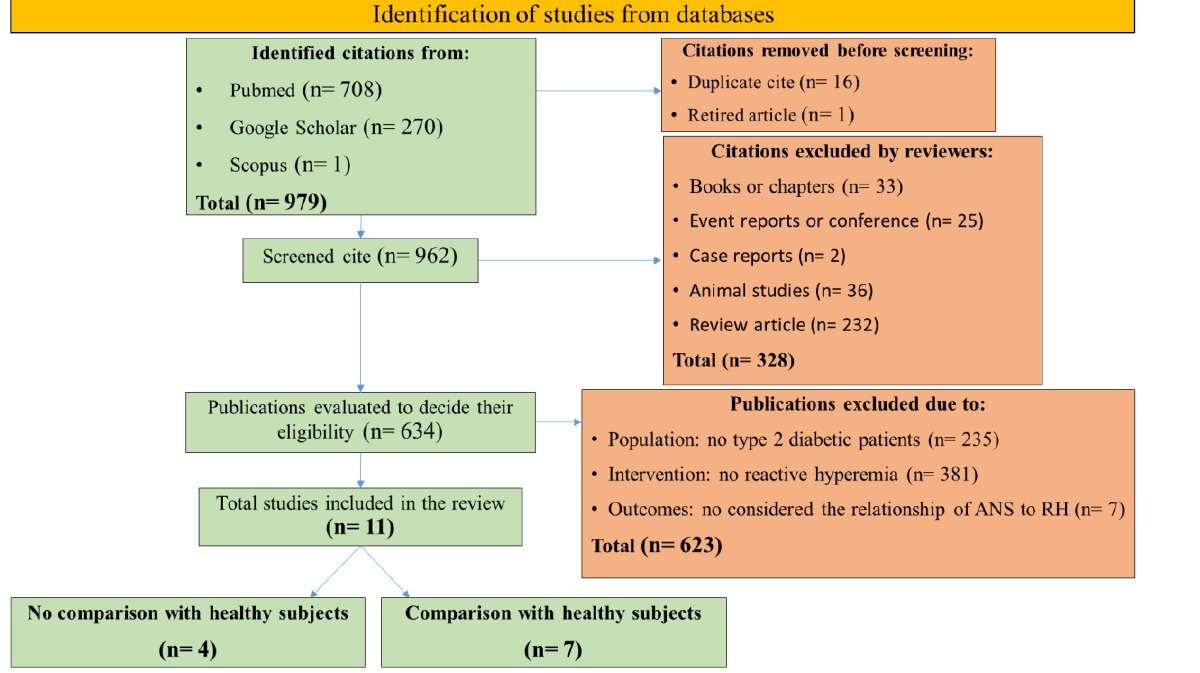
Figure 1. Flow diagram of the study inclusion process.